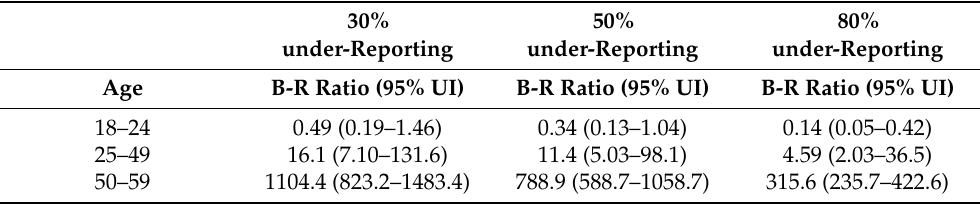
Table 3. Estimated benefit–risk [B-R] ratio of ChAdOx1 nCoV-19 vaccination, assuming different extents of under-reporting of embolic and thrombotic events.